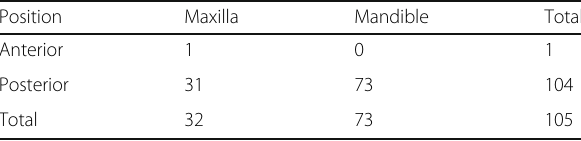
Table 2 Implant diameter and insertion distribution Diameter of the implant